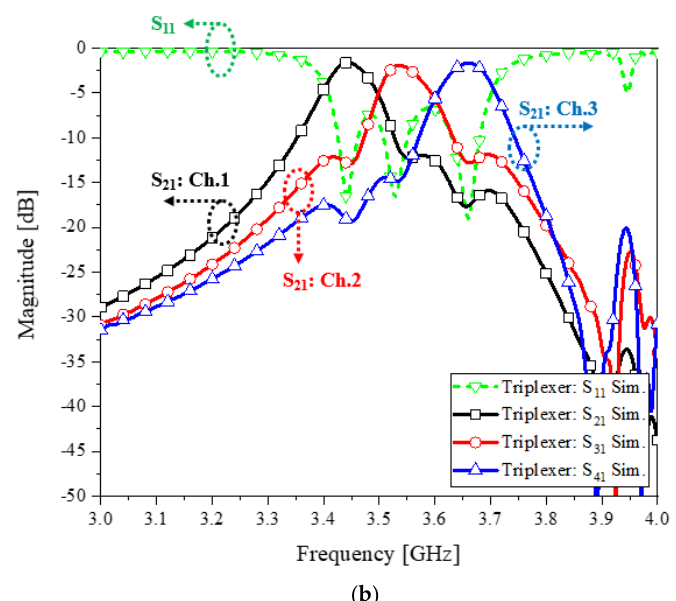
Figure 4. The compact multiplexer comprising the three channel filters. ( a ) Geometry. ( b ) The overall frequency response of the three bands.